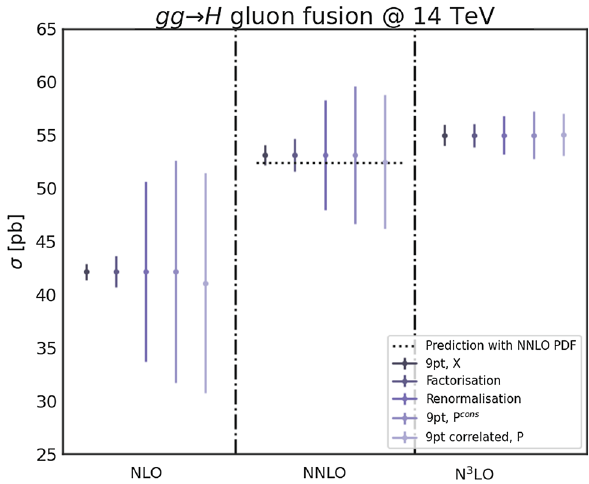
Fig. 14 Predictions for the Higgs total cross-section at 14 TeV, made using a variety of approximations. All results use NLO PDFs, while the Higgs total cross-section is computed at NLO (left panel), NNLO (cen- tre panel) and N3LO (right panel). In each panel, we then have, from left to right: MHOU included only in the PDF determination in the 9pt scheme; the same but with the factorization scale uncertainty (MHOU in PDF evolution) included in quadrature; the same but with instead the renormalization scale uncertainty (MHOU in the Higgs cross-section); the total PDF uncertainty and 9pt MHOU combined in quadrature, as recommended in Ref. [9]; the total PDF plus 9pt MHOU, but now including also the shift and the correlation between theoretical uncer- tainties. In the centre panel we also show the NNLO prediction with NNLO PDFs (but no theoretical uncertainties), as a dashed